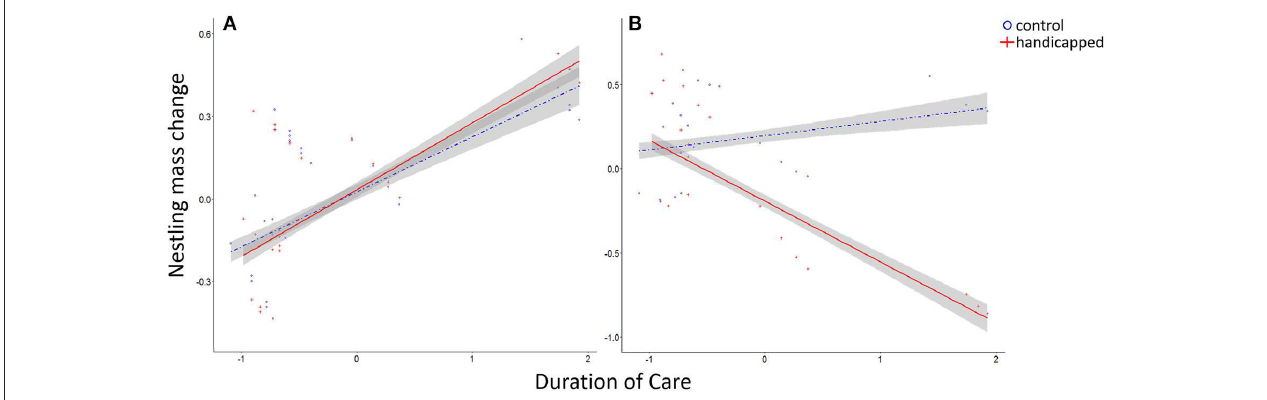
FIGURE 4 | Standardized model-predicted changes in nestling mass varied according to duration of care. (A) The change in nestling mass did not differ between the handicapped and control groups in the pre-treatment phase. (B) In the post-treatment phase, the mass of nestlings in the handicapped group decreased with an increasing duration of care, while the mass of nestlings in the control group increased with the duration of care. Shaded area represents 95% confidence interval.